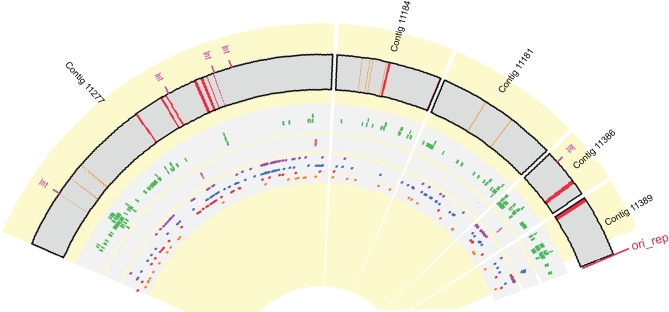
Overview of Different Source of Pangenomic Variation over a 500-kb Segment of the 5-Way CG Type Leptospirillum Group II Genome, Including the Origin of ReplicationOnly the mapped segment of the genome is shown. In the outer ring, tRNAs are indicated with orange, transposons with red, and integrases with “Int.” The location and length of strain variant paths (see main text) are shown in green in the first inner ring, and the locations of recombinant reads (blue = UBA-type, and red = non–UBA-type) are shown in the second inner ring. The innermost ring shows nonsynonymous SNPs in blue, synonymous SNPs in purple, intergenic SNPs in red, and SNPs resulting in frameshifts in orange. The image was generated with Circos (M. Krzywinski, http://mkweb.bcgsc.ca/circos/).